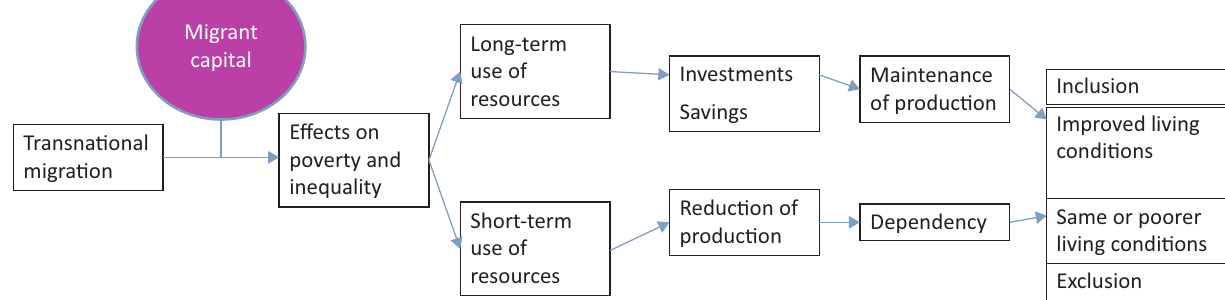
Figure 1. The use of migrant capital as an informal social protection strategy for family members left